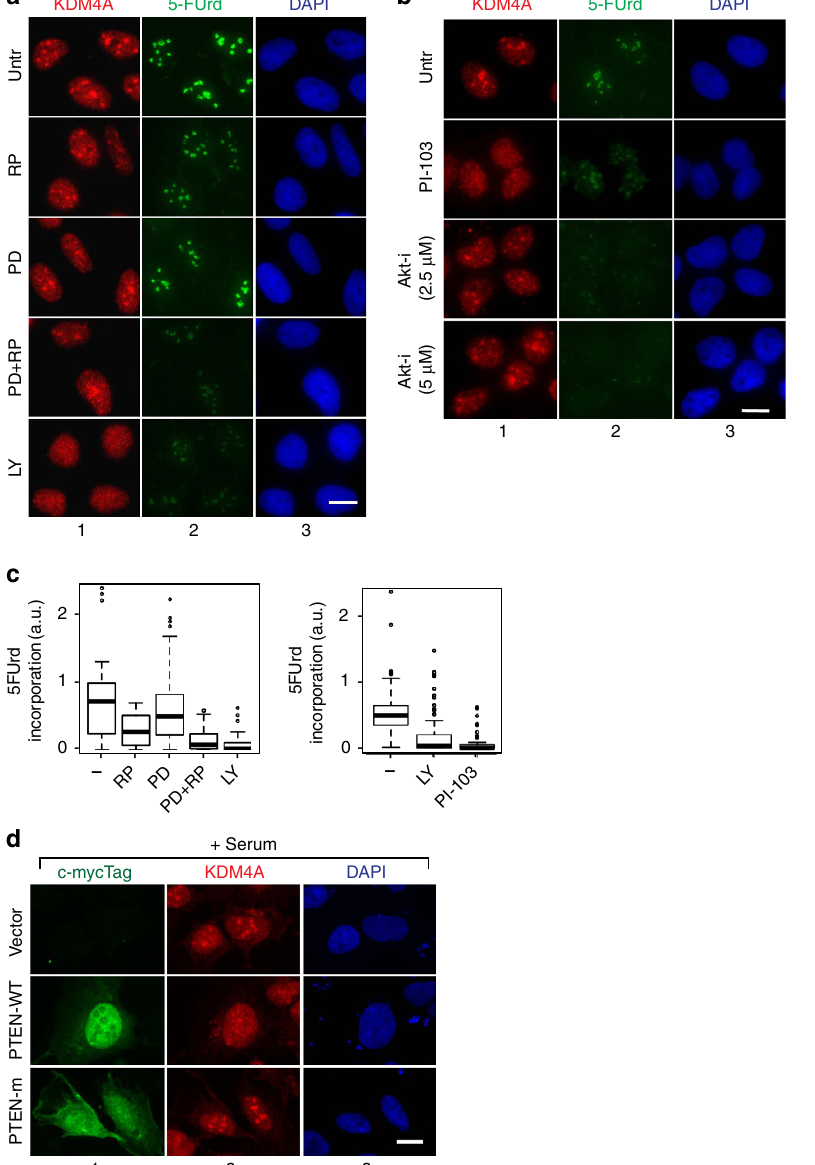
(Fig. 7b, column 1), despite having a major inhibitory effect on rDNA transcription (Fig. 7b, column 2). We thus investigated kinases downstream of PI3K, which could be important for KDM4A relocalization. One attractive